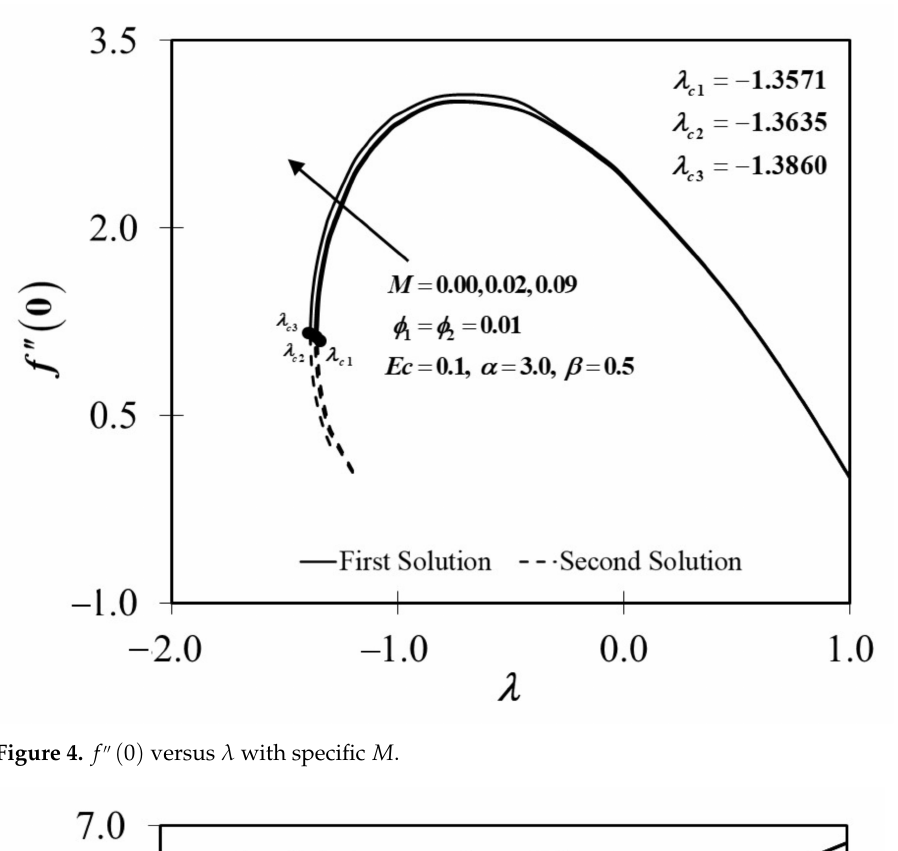
Figure 4. f (cid:48)(cid:48) ( 0 ) versus λ with specific M .